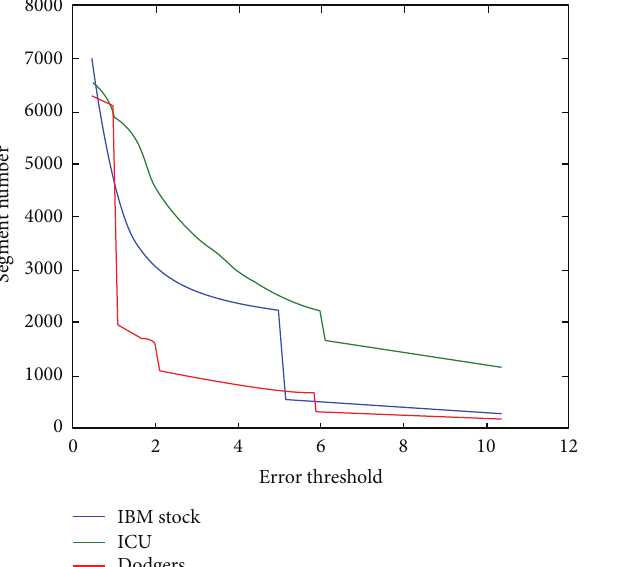
Figure 6: Relative of error threshold and segments number for BU.